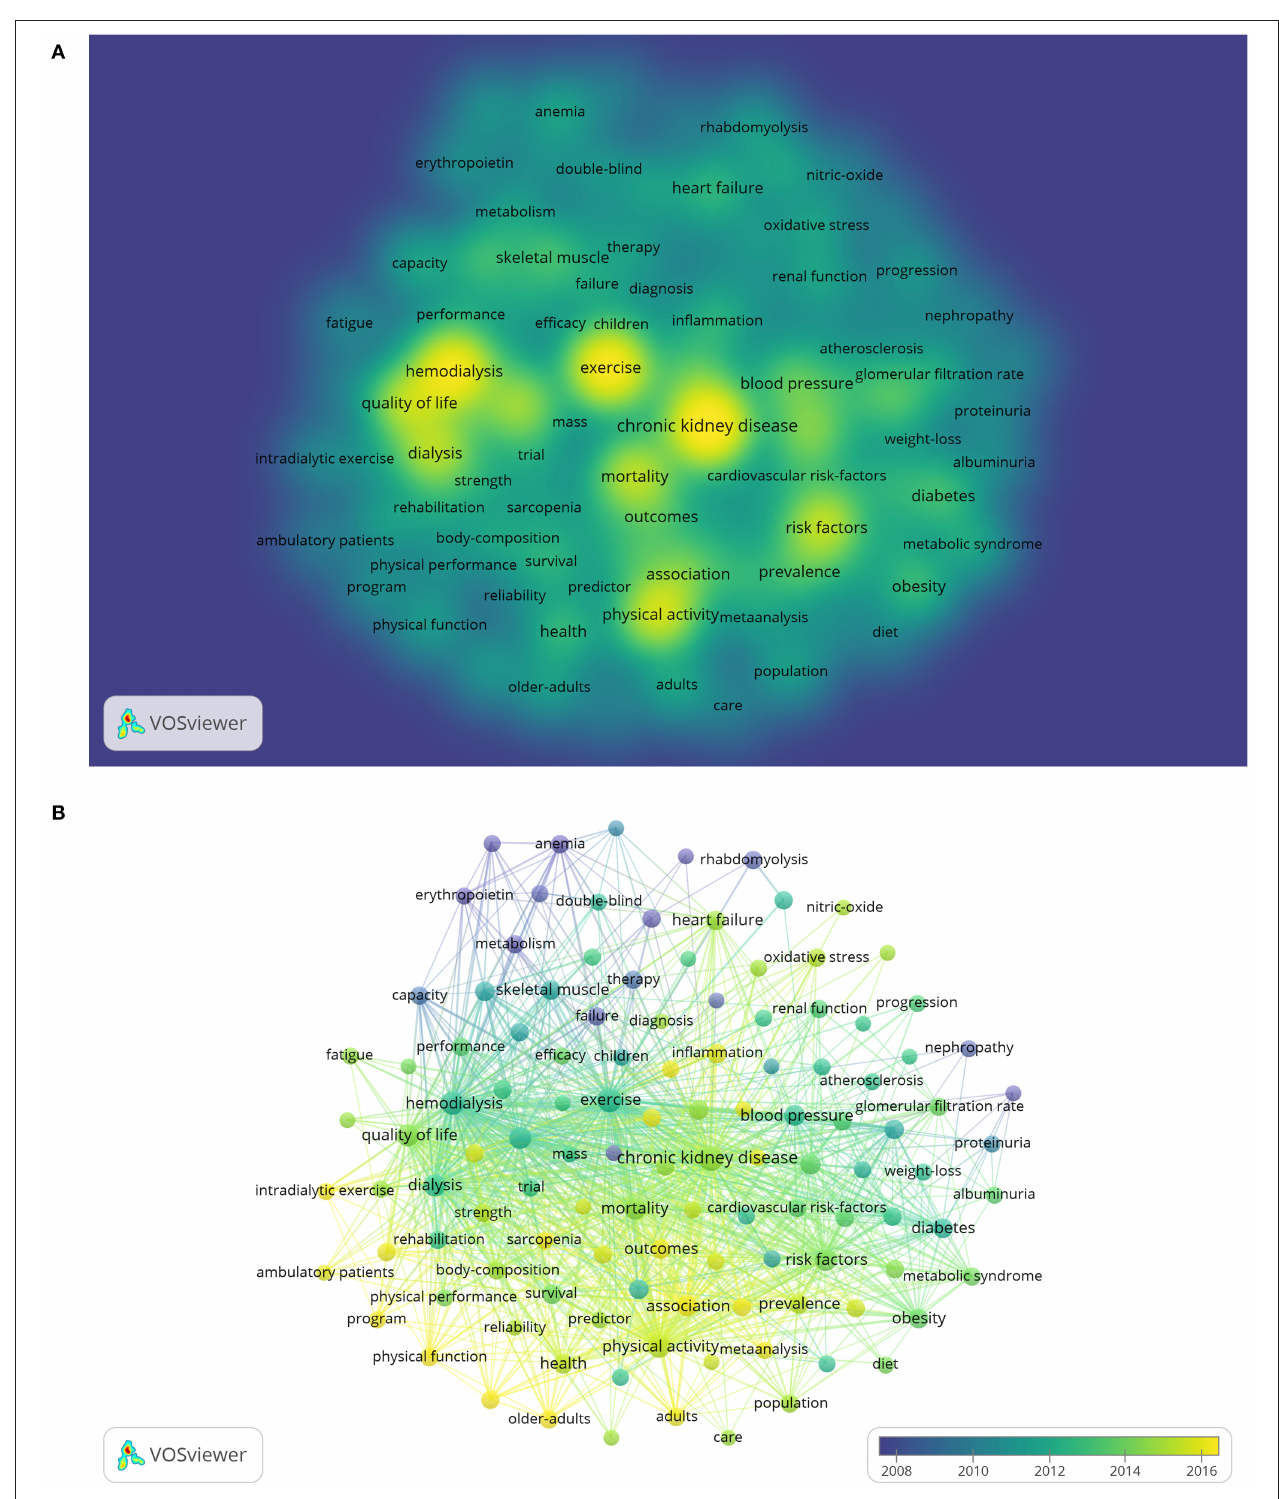
FIGURE 7 | Co-occurrence analysis of keywords. (A) Overlay visualization. (B) Density visualization.